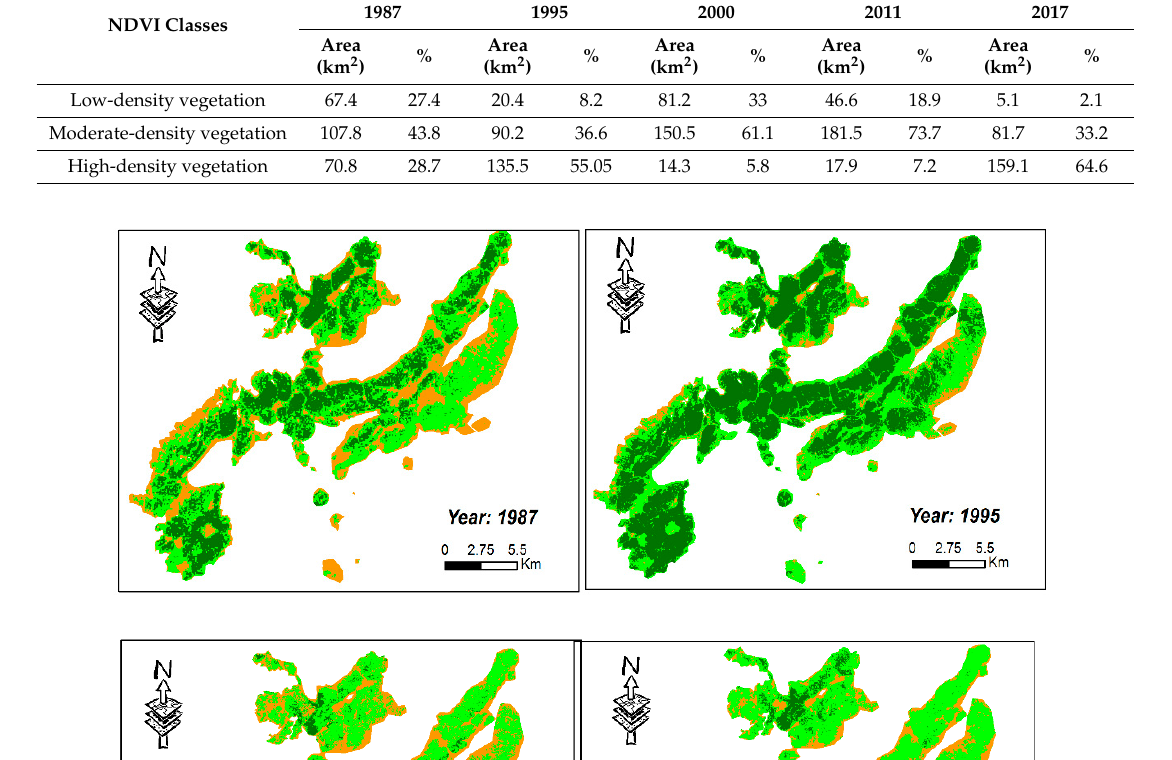
Table 6. Normalized difference vegetation index (NDVI) land cover change (in km 2 and percentage) from 1987 to 2017.